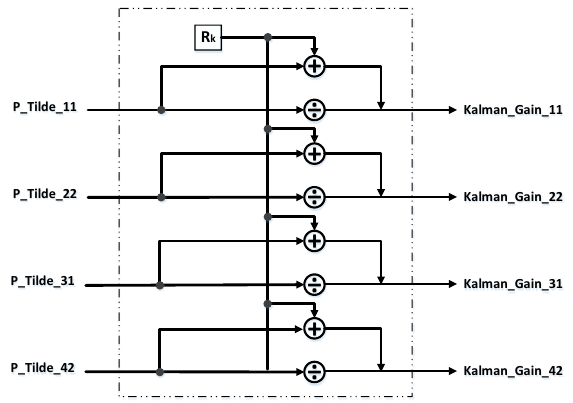
Figure 6. VLSI architecture of the Kalman gain and α , β module.